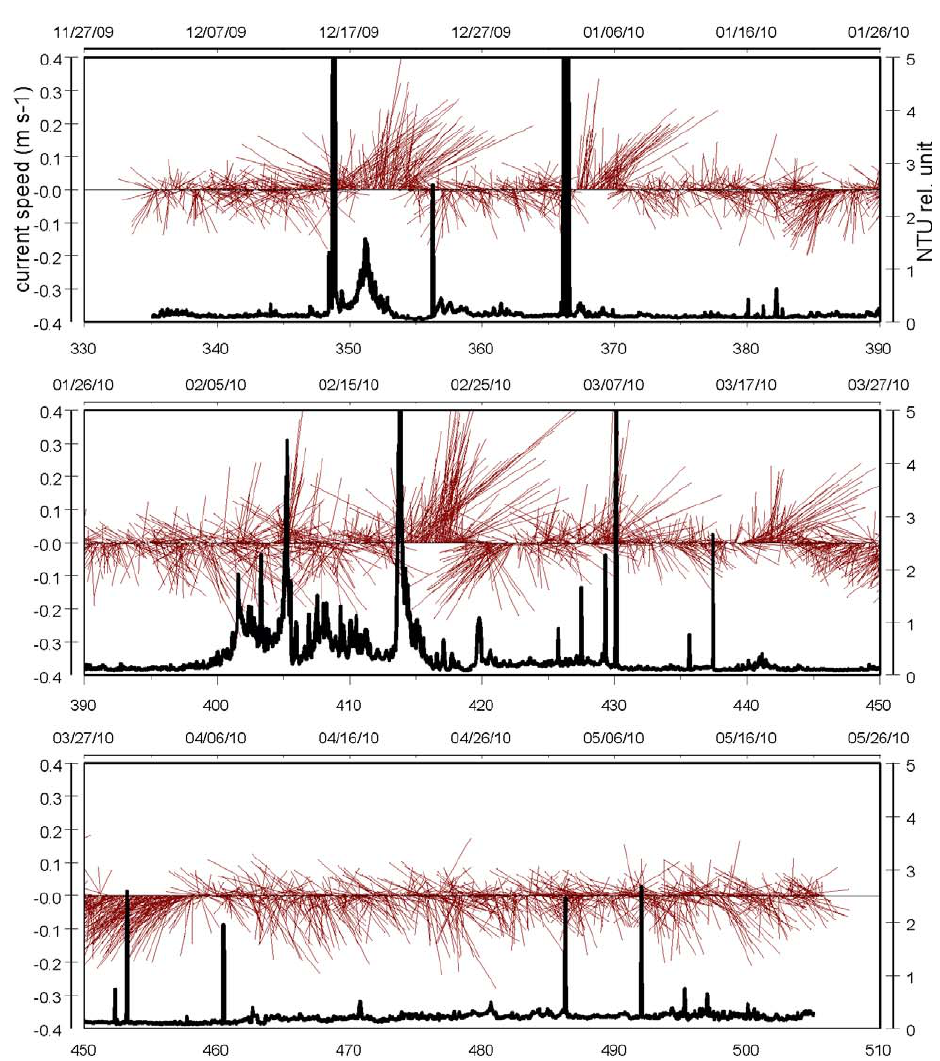
Fig. 10. Current speed and direction (stick plot), in combination with turbidity during 6-month deployment. The lower x axis gives days since 1 January 2009, while the upper x axis gives the true